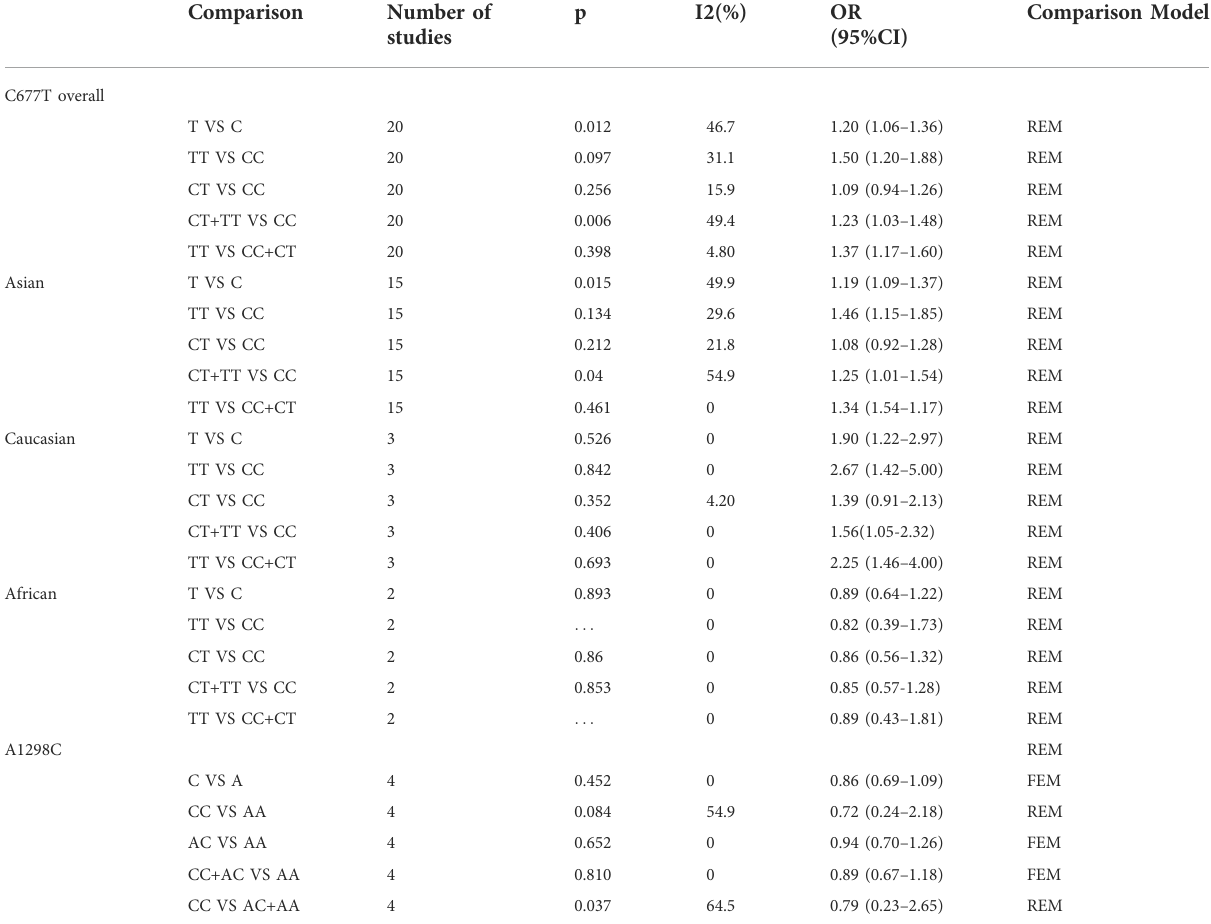
TABLE 3 Results of association between C677T and A1298C with intracerebral hemorrhage in this meta-analysis.